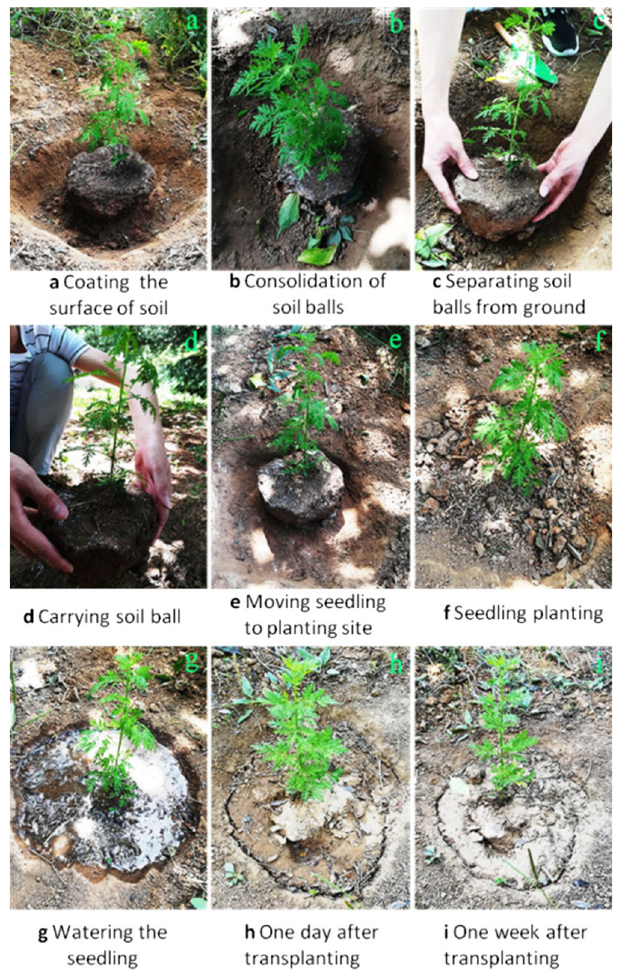
Figure 9. Process of transplanting sierra salvia with soil consolidation